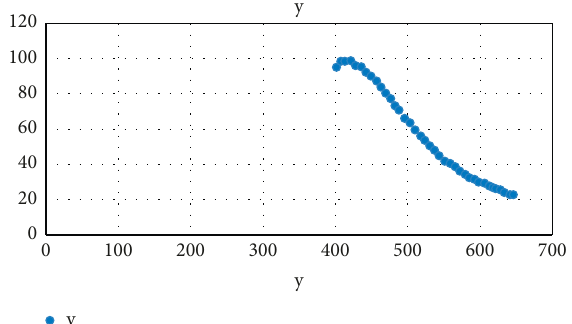
Figure 9: An examination of the arriving light intensities in six polarisations at zero angle. The wavelength is shown on the hor- izontal axis